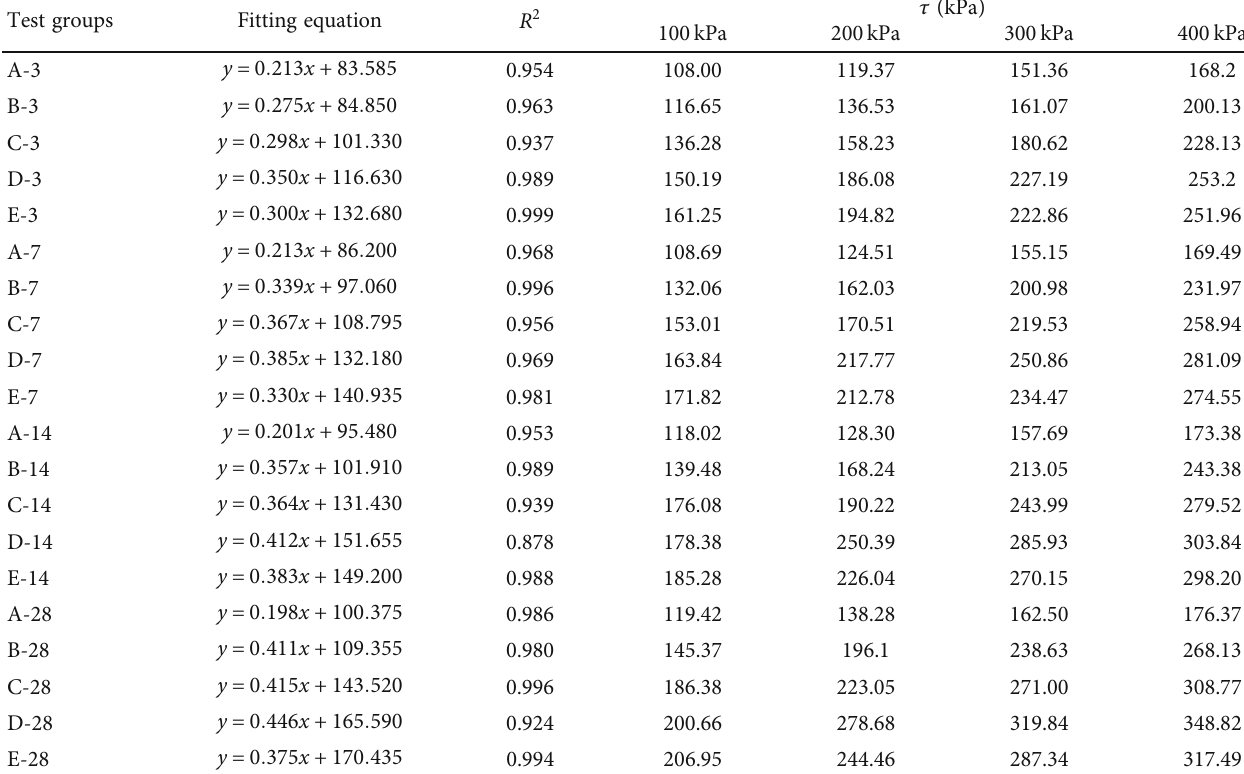
Table 4: Results of shear strength in direct shear